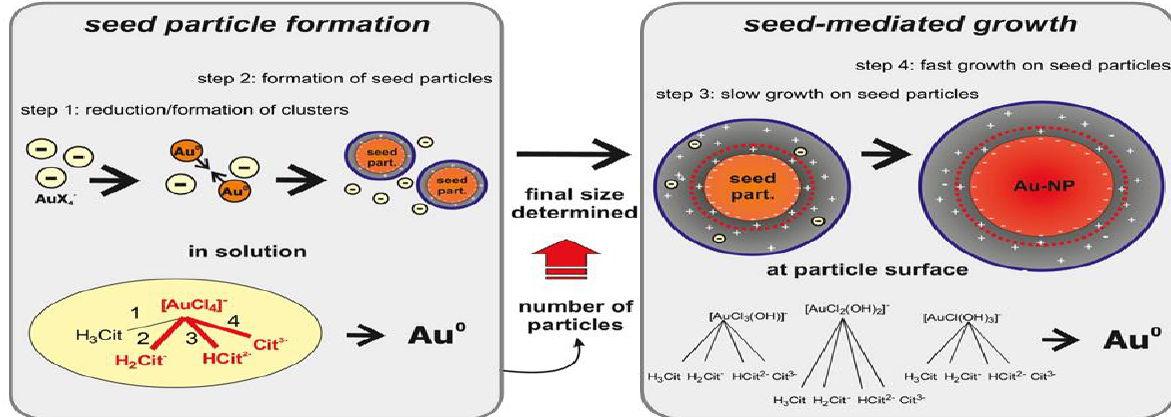
Figure 1. Gold nanoparticles formation by seed-mediated growth mechanism (12)